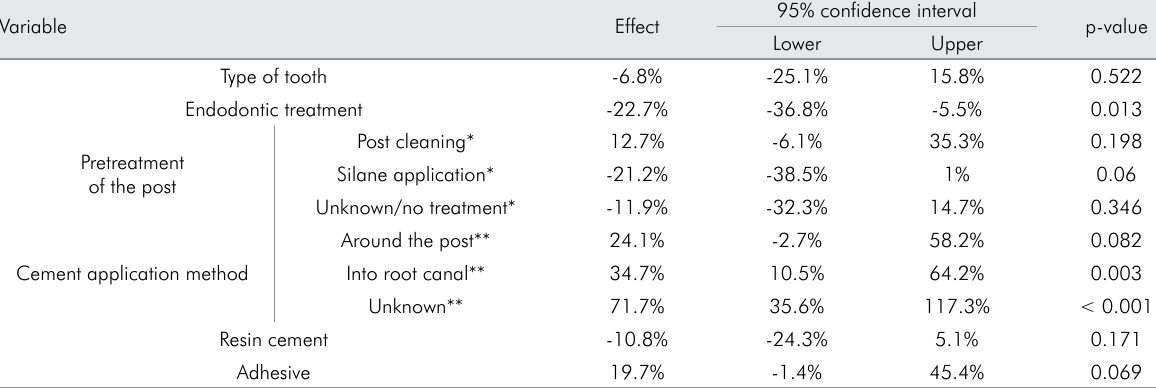
Table 2. Regression model considering all data (r-square =